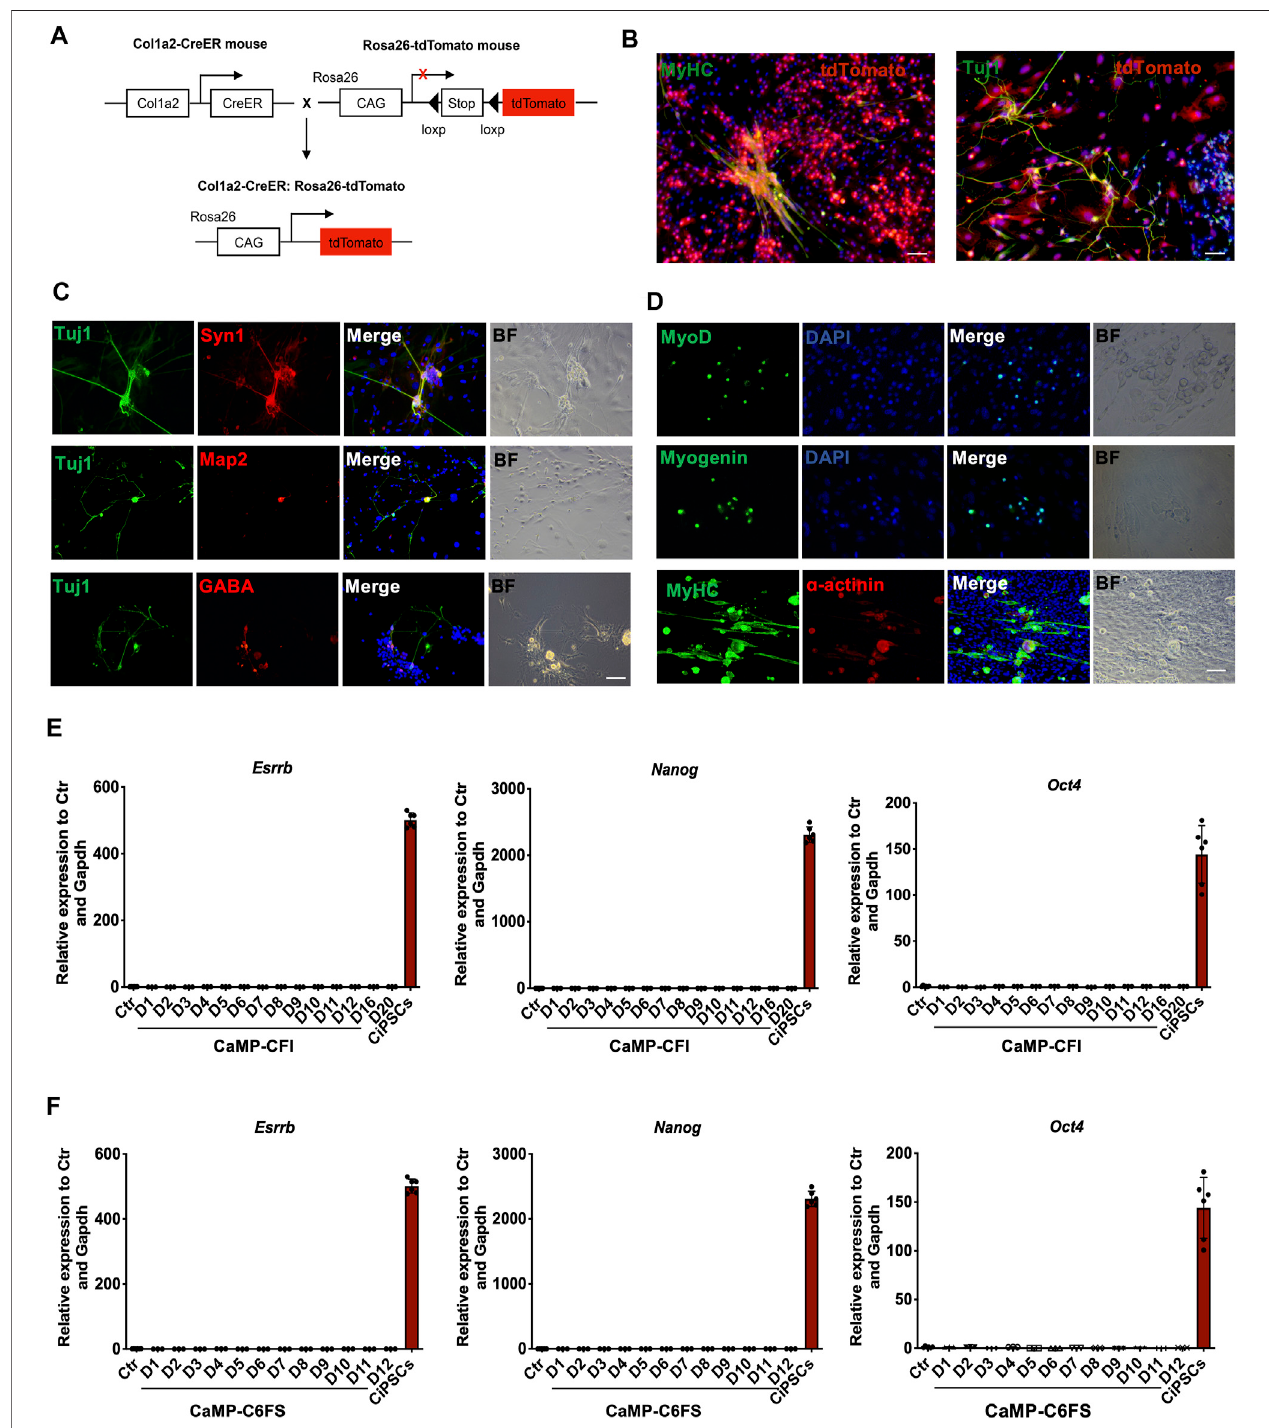
FIGURE 7 | Cells induced from the CaMP state are not derived from progenitor cells or pluripotent stem cells. (A) Schematic diagram of Col1a2-derived lineage- tracing system. (B) Immuno fl uorescence for Tuj1-positive neuron-like cells and MyHC-positive myocytes that induced from Col1a2-positive fi broblasts. (C) Immunostaining for neuron-like cells induced from TTFs with CaMP pretreatment. Scale bar, 100 μ m. (D) Immunostaining for skeletal muscle cells induced from TTFs with CaMP pretreatment. Scale bar, 100 μ m. (E) Relative mRNA expression of hallmark pluripotent genes ( Nanog , Oct4 , and Esrrb ) through the neuron-like cells induction process. (F) Relative mRNA expression of hallmark pluripotent genes (Nanog, Oct4 , and Esrrb ) through the skeletal muscle cells induction process. Data are presented as mean ± SD, *** p < 0.001; ** p < 0.01; * p < 0.05, t -test.